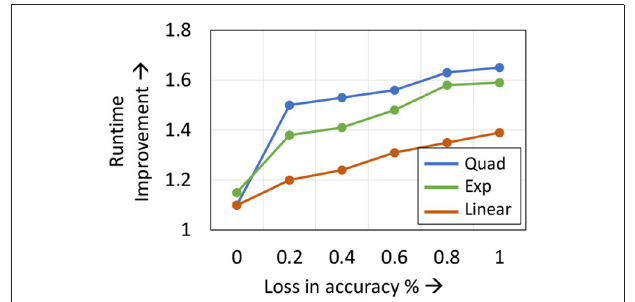
FIGURE 4 | Impact of different scheduling functions on Cifar10-ResNet18 training.